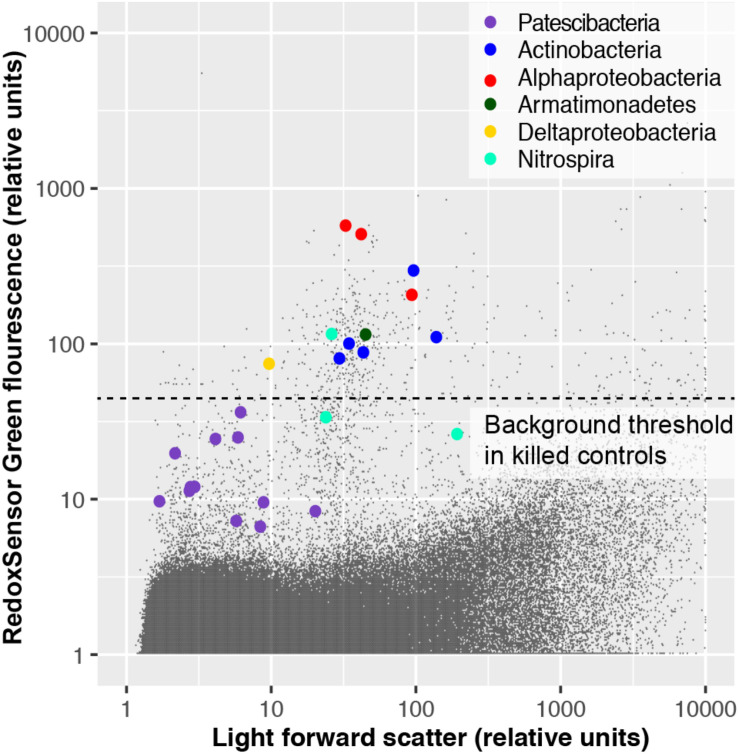
Oxidoreductase activity in subsurface (∼300 m below surface) microbial cells from Homestake Mine (Lead, SD, United States) probed by RedoxSensor Green (RSG; Thermo Fisher).